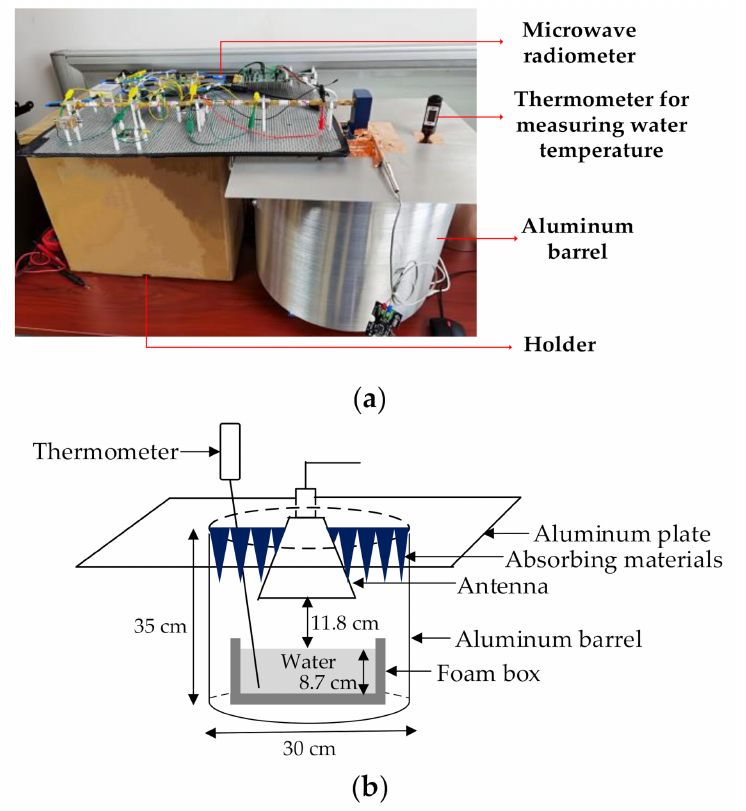
Figure 11. Device diagram of novel interferometric microwave radiometer. ( a ) Actual picture of interferometric microwave radiometer; ( b ) diagram of signal acquisition device of interferometric microwave